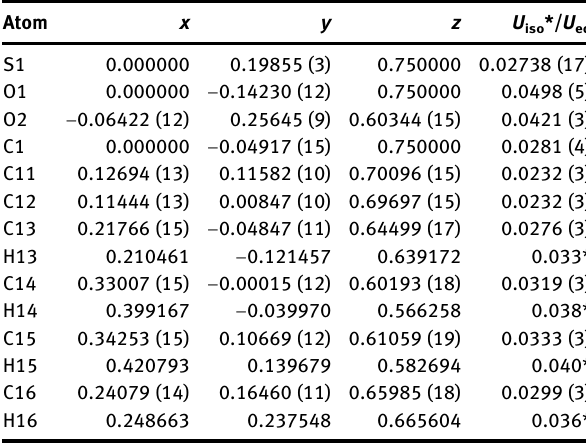
Table  : Fractional atomic coordinates and isotropic or equivalent isotropic displacement parameters (Å 